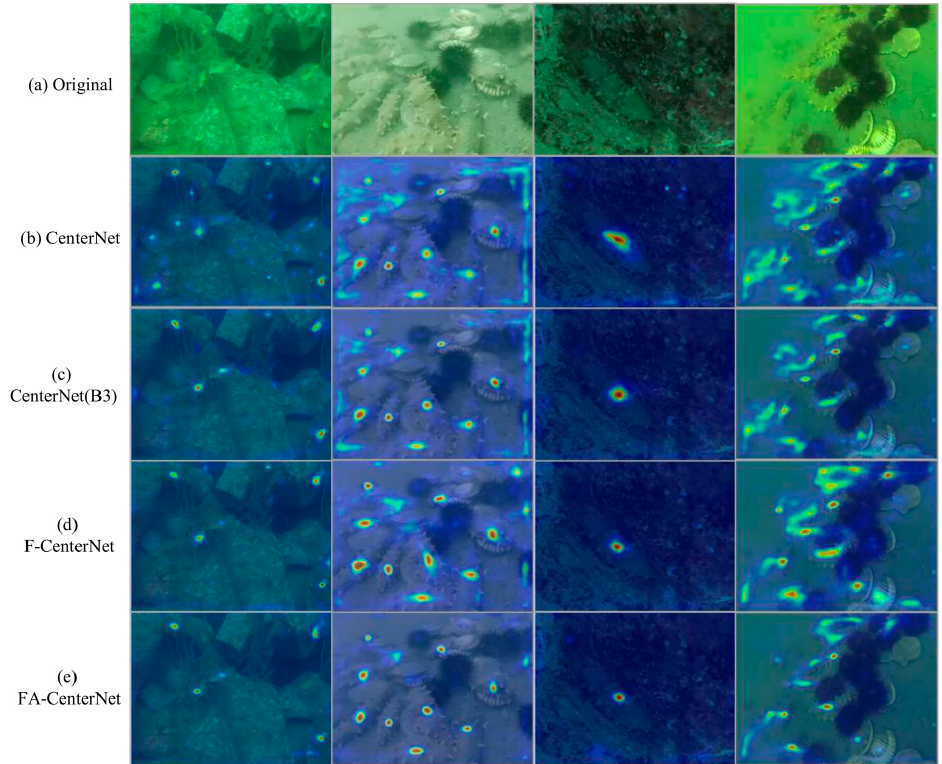
Figure 10. Visualizing heat maps of four models. ( a ) Original Input Pictures. ( b ) Heatmap visualization of the CenterNet. ( c ) Heatmap visualization of the CenterNet(B3). ( d ) Heatmap visualization of the F-CenterNet. ( e ) Heatmap visualization of the FA-CenterNet.